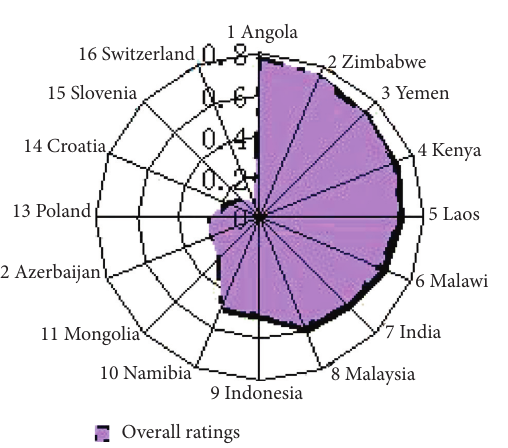
Figure 2: Distribution maps of comprehensive score. Table 5: The rating level. Comprehensive